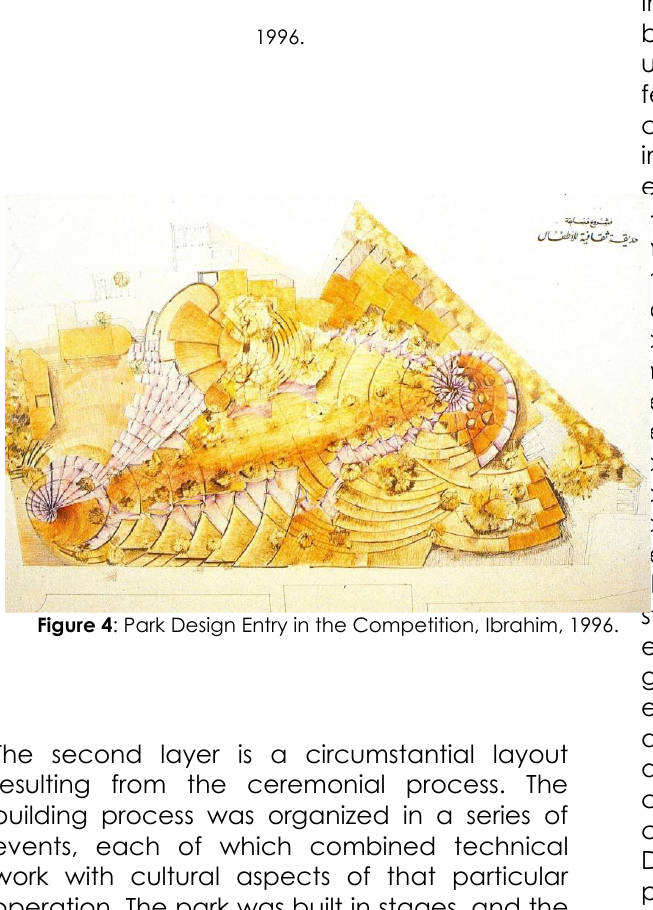
Figure 3 : Development of Park Design Concept, Ibrahim,